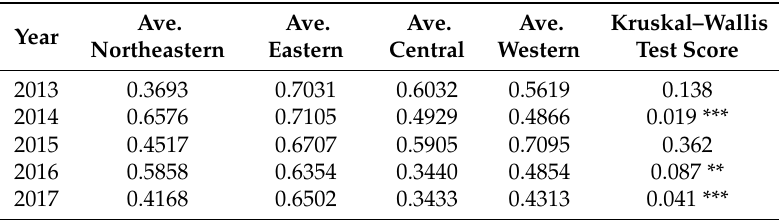
Table 6. Kruskal–Wallis H Test Score of total e ffi